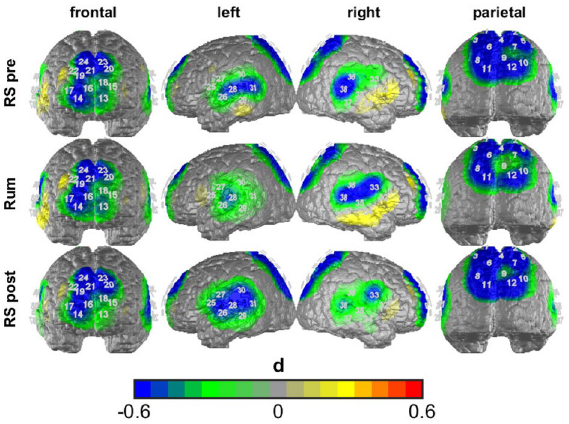
Figure 3. Differences between the MDD group and the HC group in ALFF during the different experimental conditions. Cold colors indicate higher activation in the HC than in the MDD, warm colors indicate higher activation in the MDD than in the